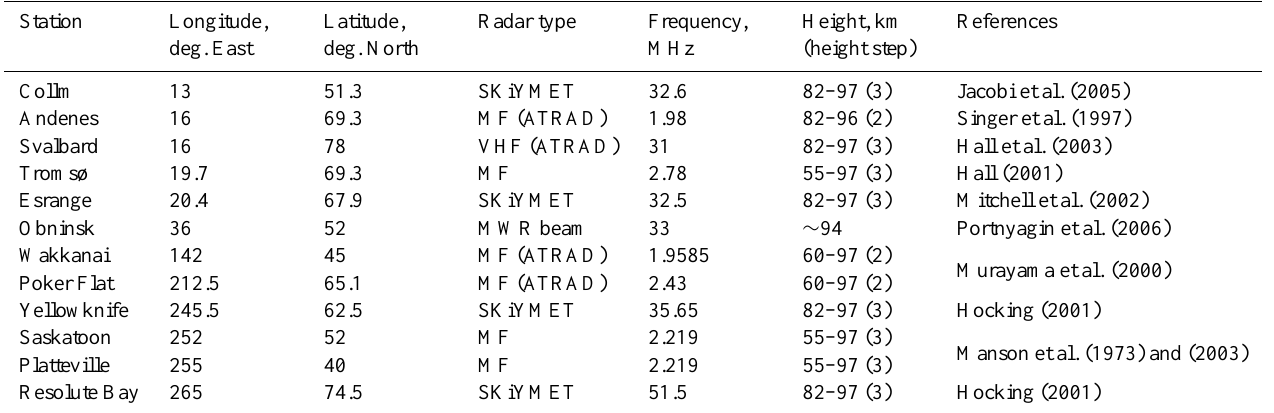
Table 1. Characteristics of the